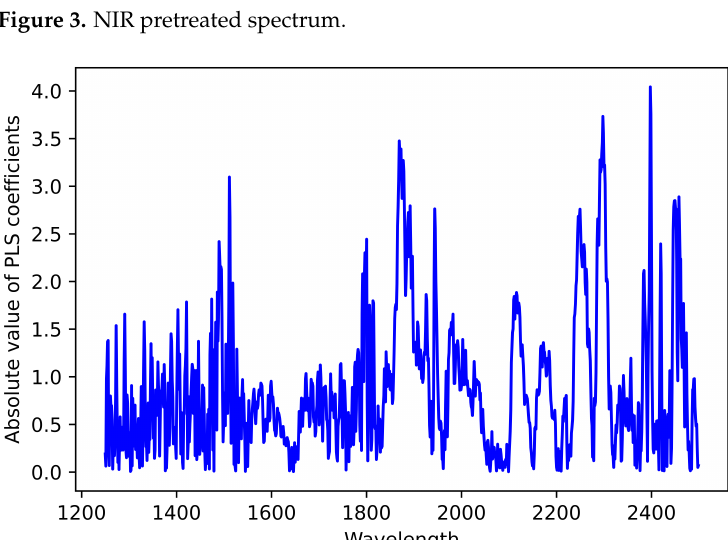
Figure 4. PLS regression coefficients absolute values against each wavelength for nitrogen